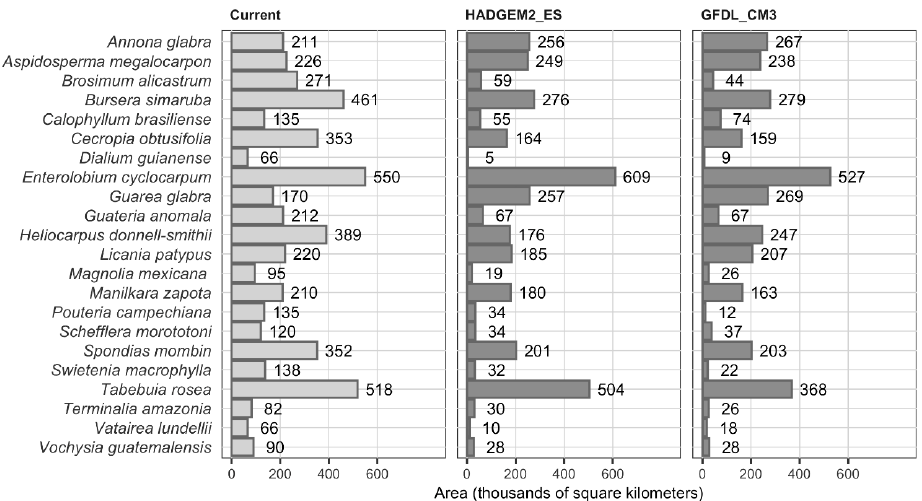
Figure 5. Potential distribution area in the scenarios considered. The darker gray color indicates the climate change scenarios.